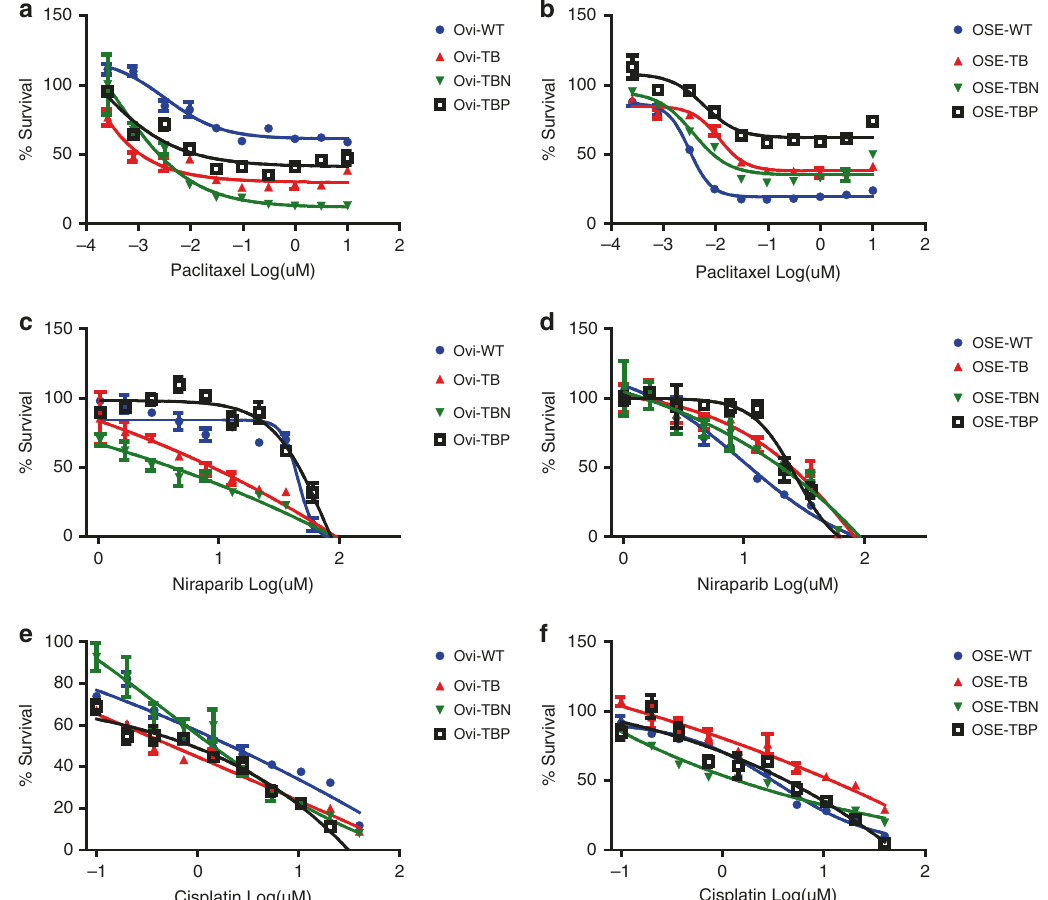
Fig. 4 In vitro drug sensitivity of oviductal and OSE lines. a , b Representative dose – response curves of paclitaxel-treated a oviductal and b OSE clones. c , d Representative dose – response curves of niraparib-treated c oviductal and d OSE clones. e , f Representative dose – response curves of cisplatin treated e oviductal and f OSE clones. a – f Error bars represent ±SEM of quadruplicates ( n = 4) over two independent experiments. Ovi — oviduct; OSE — ovarian surface epithelium; WT — wild type; TB — Trp53, Brca1 mutant; TBN — Trp53, Brca1, Nf1 mutant; TBP — Trp53, Brca1, Pten